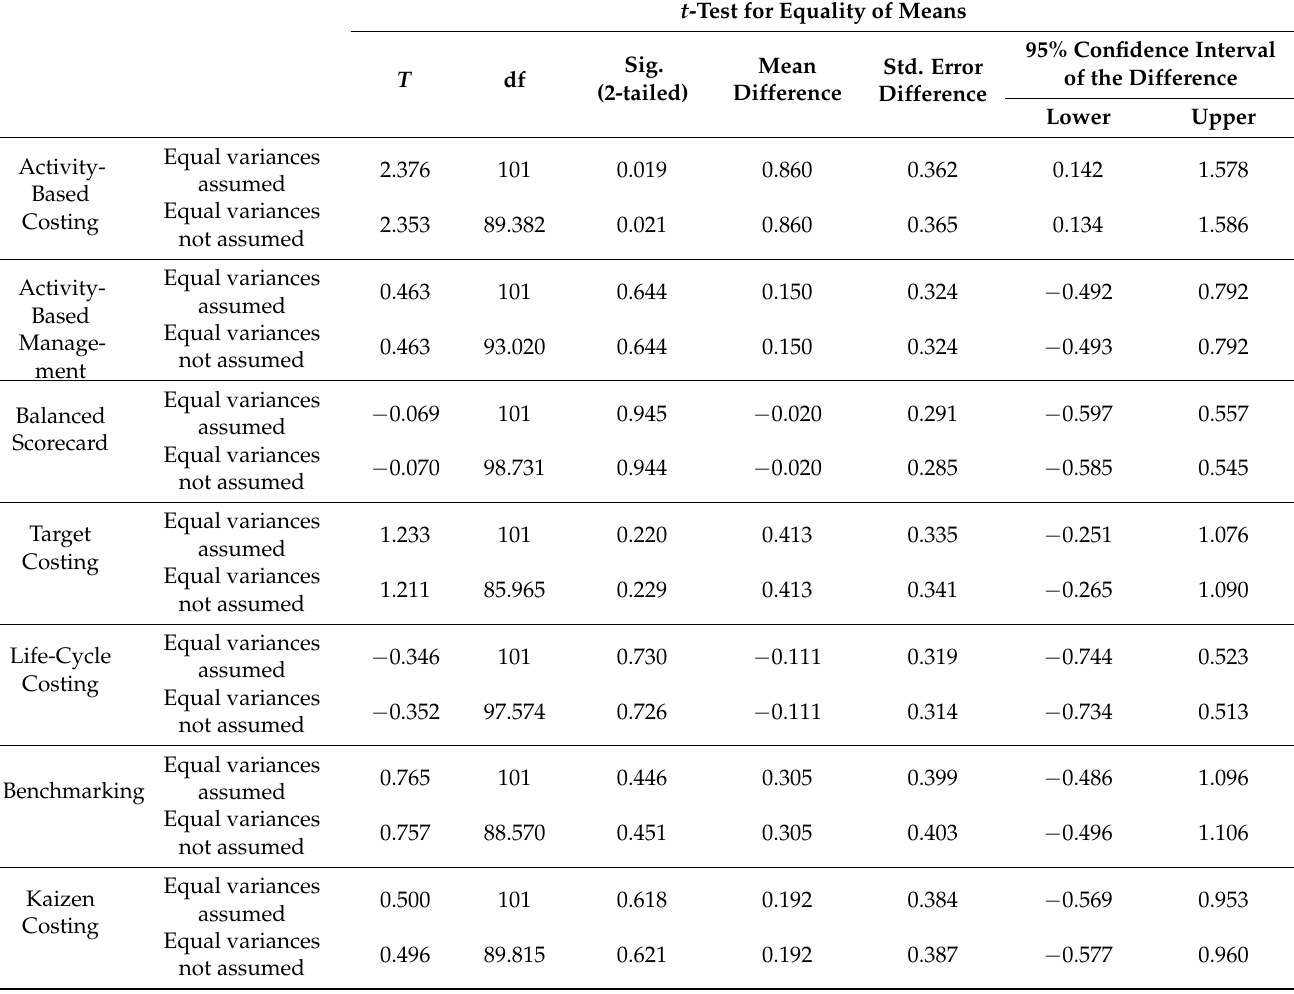
Table 15. Independent sample